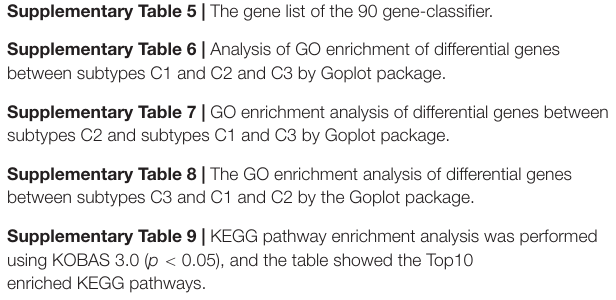
Supplementary Figure 3 | Mutation profiling of 90-gene classifier in the pan-cancer analysis and the TF-mRNA-miRNA network construction. (A) The gene mutation and gene copy number of 90-gene classifier in 32 TCGA pan-cancer databases were obtained from the cBioportal online database, and